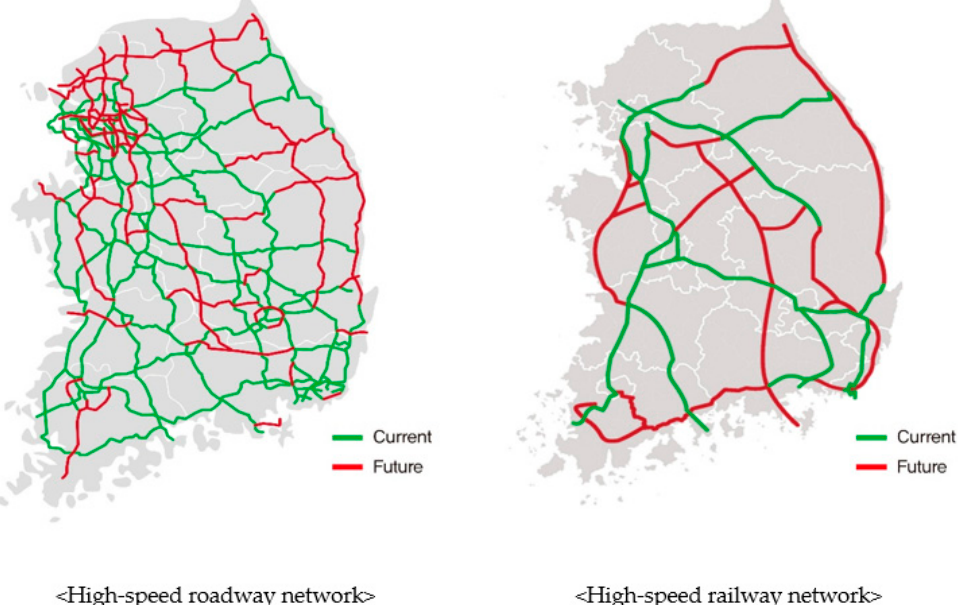
Figure 1. Current and future intercity high-speed roadway and railway network.